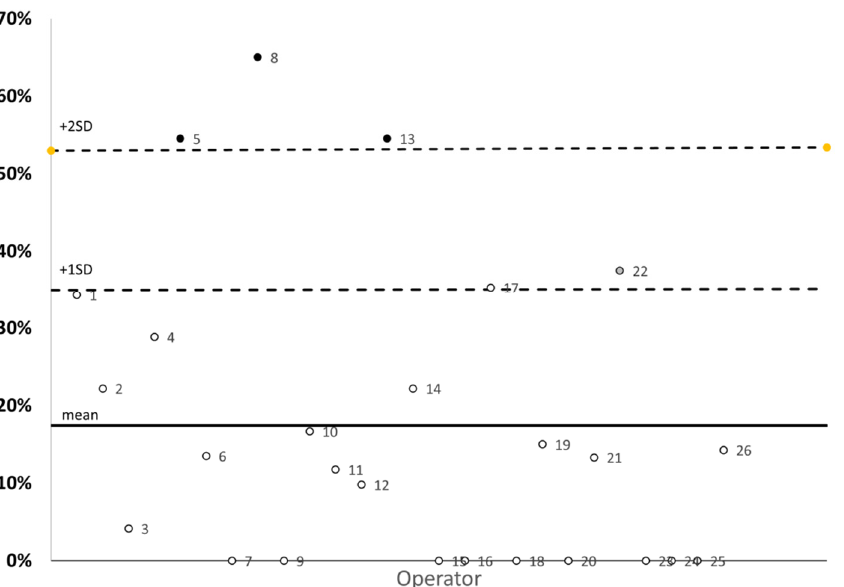
Figure 1. Percentage of hemolysis of each operator in the study. ○ , operators included in the statistical analysis, ● , operators excluded in the statistical analysis, Table 2. Final Group. Operators 5, 8, and 13 showed a percentage of hemolysins of 55%, 65% and 55%, respectively, which was much higher than the average percentage of hemolysis. n